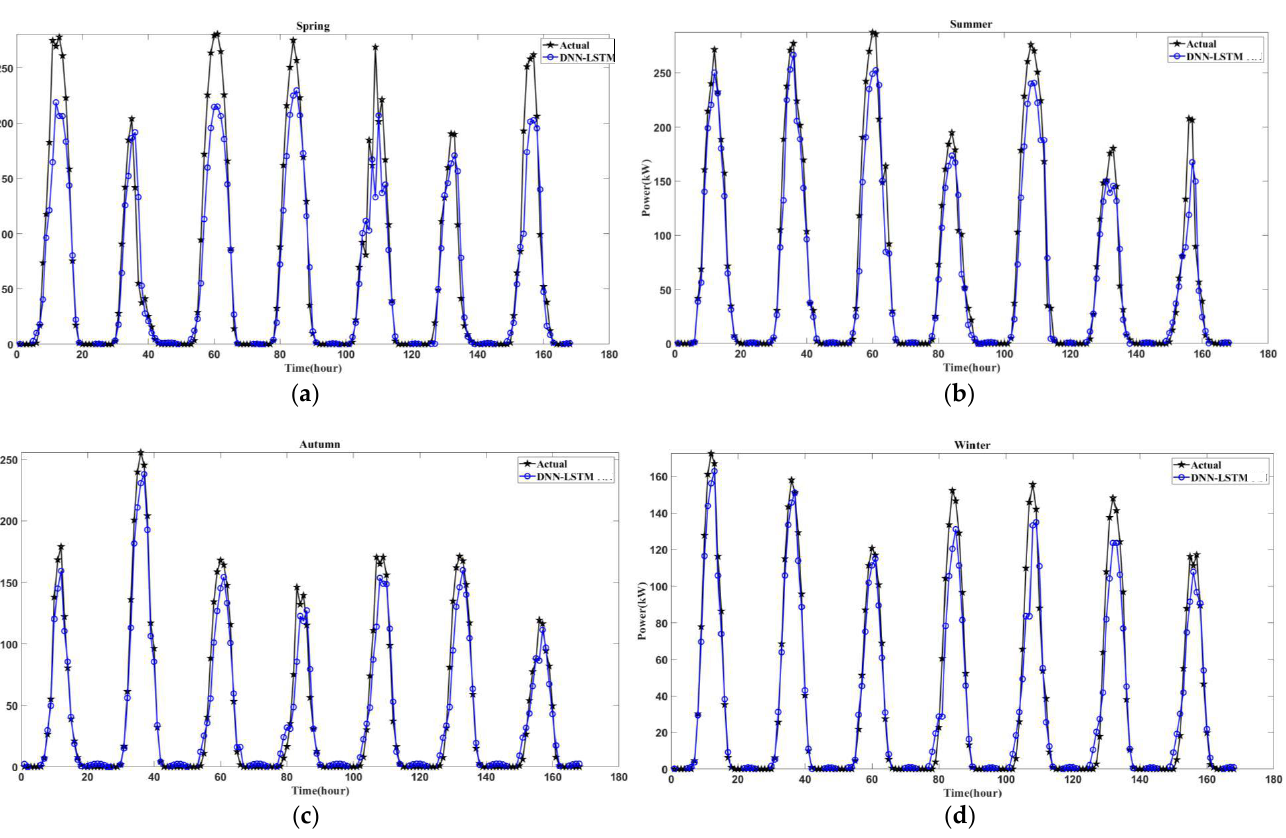
average value of 5.1% of nRMSE, and an average accuracy of 97.13%.